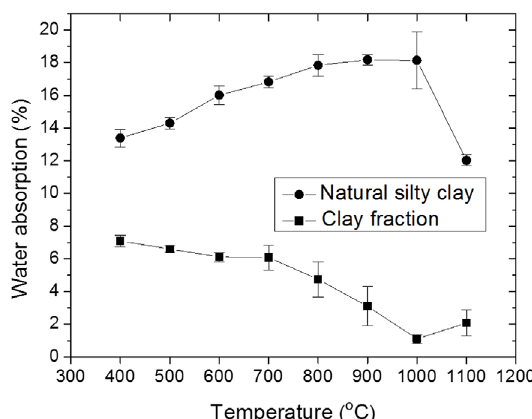
Figure 7. Variation of the water absorption as function of the firing